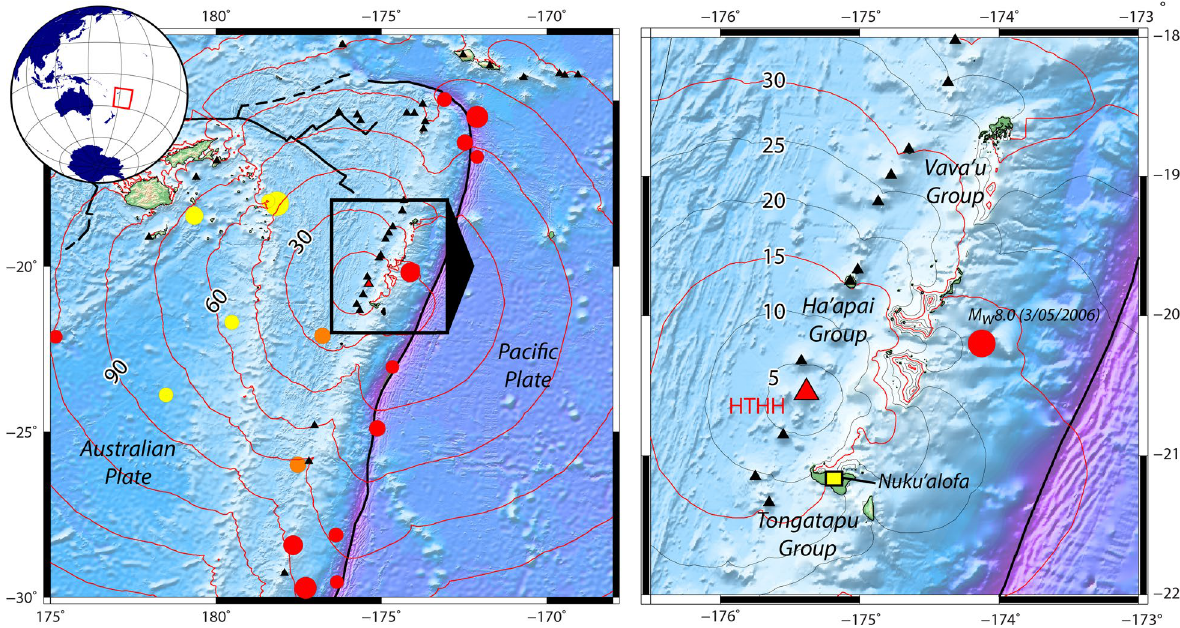
Fig. 1 Geological hazards in Tonga. Left panel (framed by red rectangle on globe): seismotectonics around the Tonga–Kermadec subduction zone. Right panel (framed by black rectangle in left panel): the three main island groups of Tonga (Vava’u, Ha’apai and Tongatapu). Circles: epicentres of magnitude Mw > 7.5 earthquakes (circle sizes proportional to magnitude; USGS data from January 1970 to February 2022) with color as a function of focal depth: shallow (red), intermediate (orange), deep (yellow). Black lines: main tectonic features (subduction trench, spreading ridges). Black triangles: active Holocene volcanoes (https:// volca no. si. edu, accessed on February 13, 2022). Red triangle: Hunga Tonga-Hunga Ha’apai (HTHH) volcano. Red and black contours: tsunami travel times from the volcano, in minutes (calculated using Mirone Software; Luis 2007). Bathymetric data from GEBCO (2014). Map generated using Generic Mapping Tools (Wessel et al.